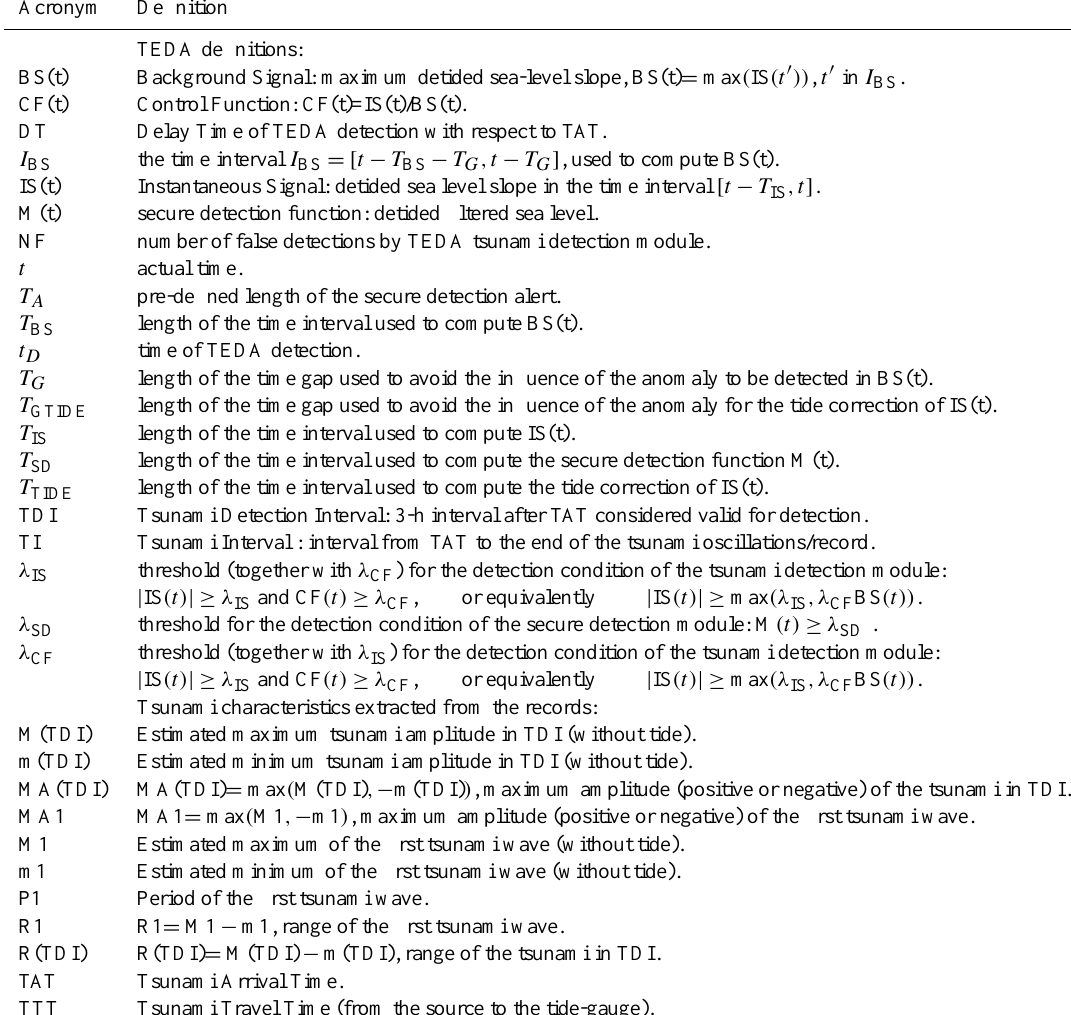
Table 3. Acronyms and